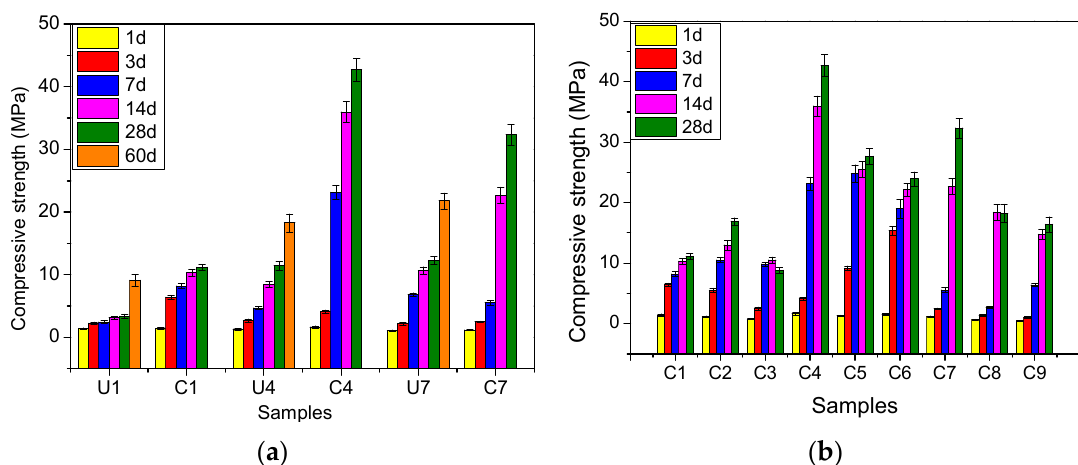
Figure 4. Compressive strength results. ( a ) Comparison between the air ‐ cured and carbon ‐ cured samples, ( b ) all of the carbon ‐ cured samples.